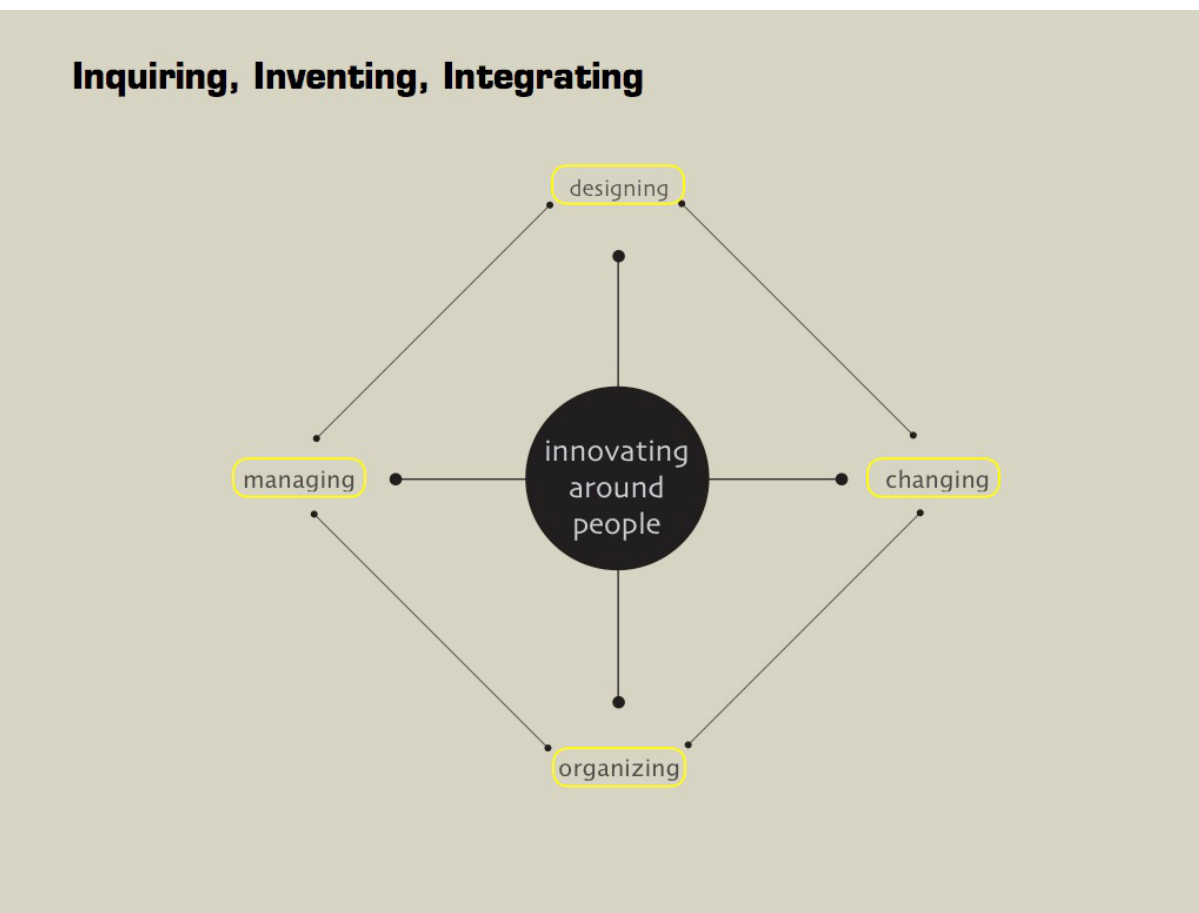
Figure 1: The Four Core Organizational Activities: Designing, Changing, Organizing, and Managing